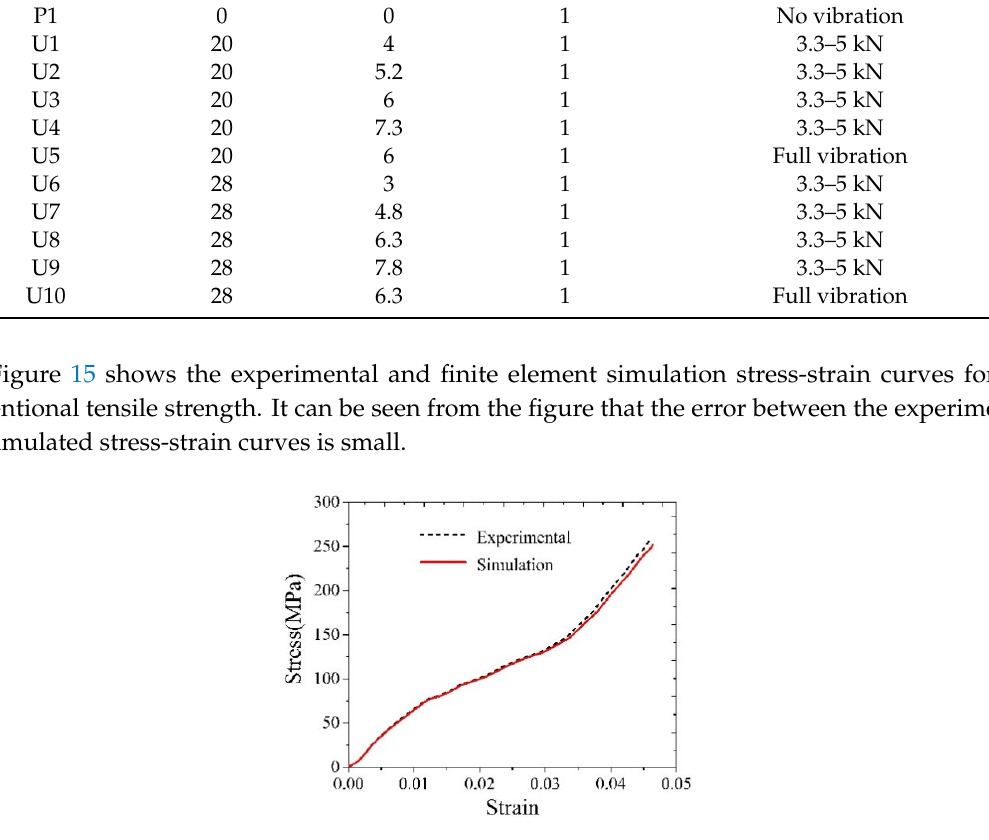
Figure 15. The experimental and finite element simulation stress-strain curve during conventional tensile strength.